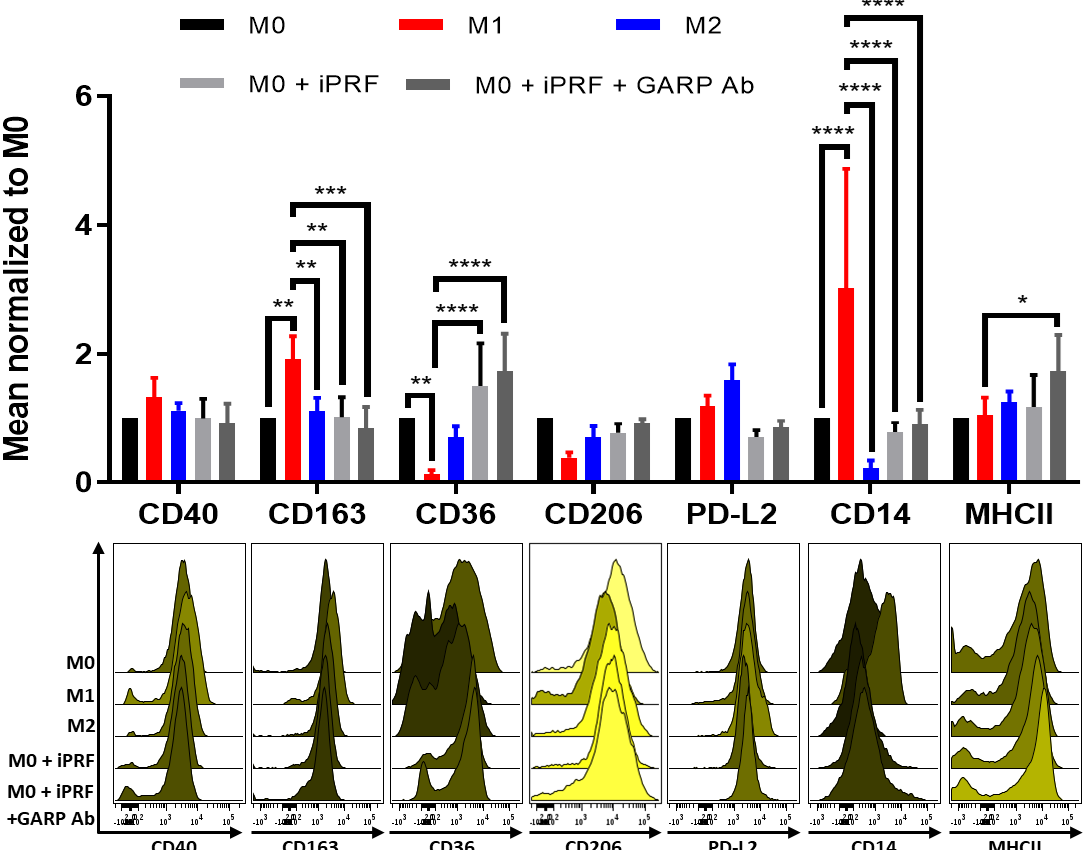
Figure 4. Liquid platelet rich fibrin (iPRF) polarizes M0-macrophages in a more “M0/M2-like” phenotype through a GARP independent mechanism. Human monocyte derived macrophages were polarized, treated with 400 µL iPRF/well, 10 μ g/mL anti-GARP antibody (Ab) or were left untreated for 2 days as indicated. Surface marker expression was analyzed via flow cytometry. Bar diagram shows the mean fluorescence intensity (MFI) of each surface marker normalized to the respective M0 control. Representative histograms of 3 independent experiments are shown (n = 5 donors, bar means ± SD, * p < 0.05, ** p < 0.01, *** p < 0.001, and **** p < 0.0001 determined by two-way ANOVA).